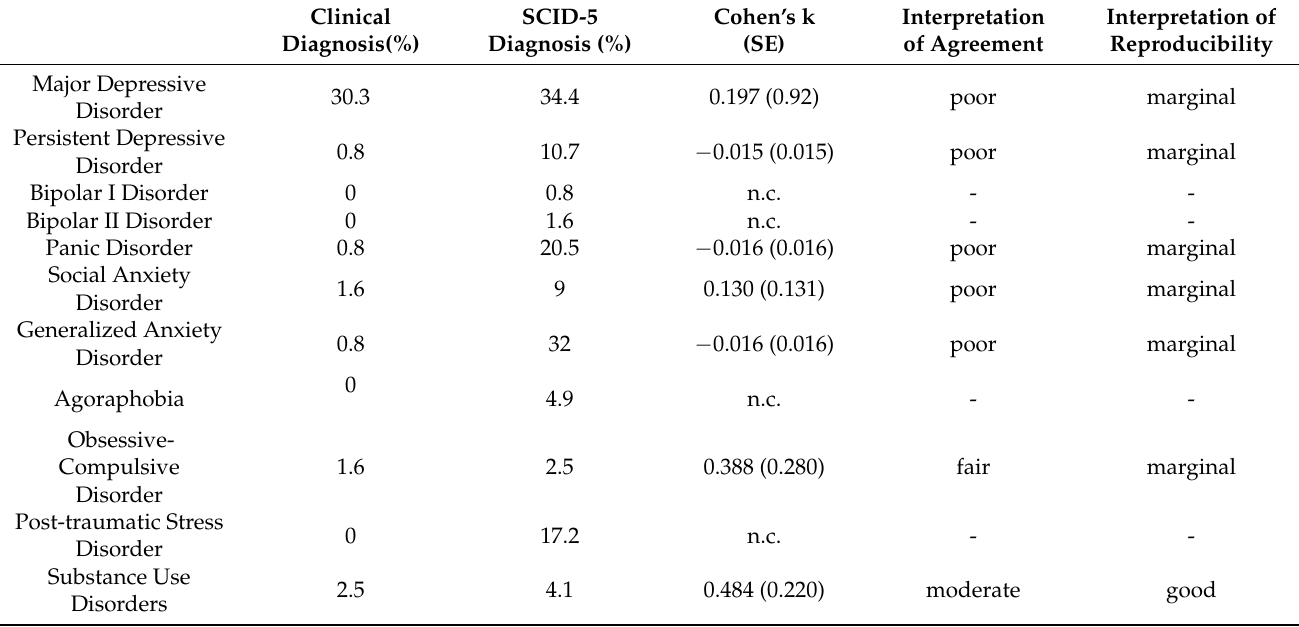
Table 1. Concordance between clinical and SCID-5 diagnosis in the total sample of patients with